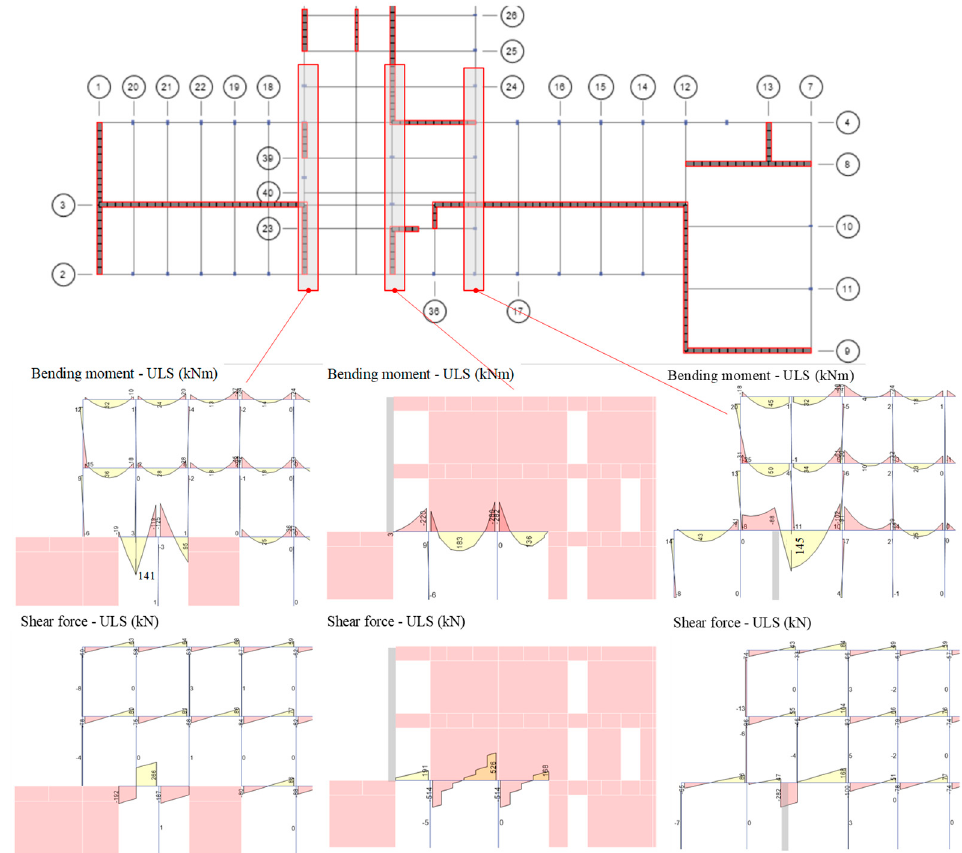
Figure 12. Weak positions in the structure due to vertical loads.